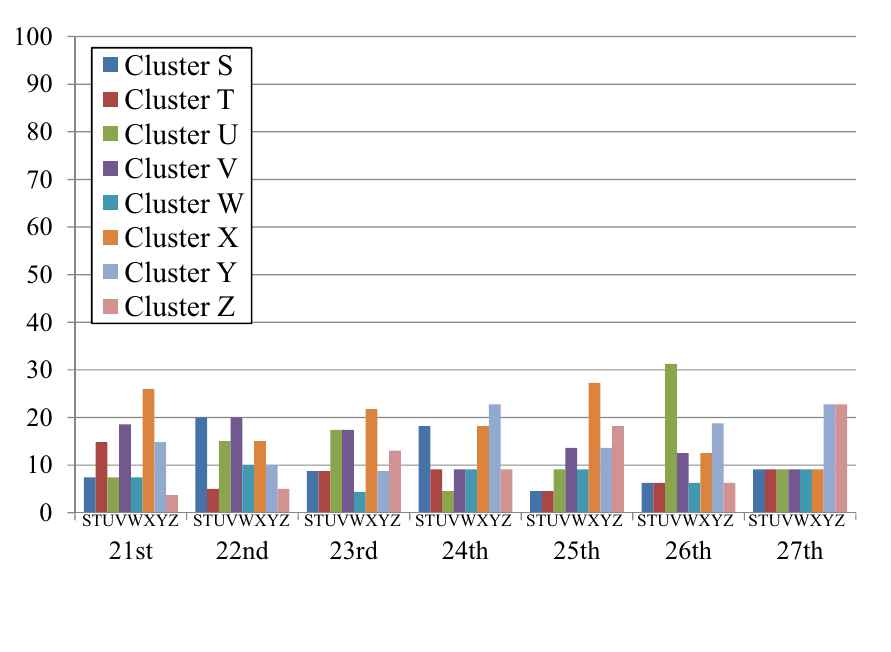
Figure 9. Distribution of temperature in each cluster based on k-means